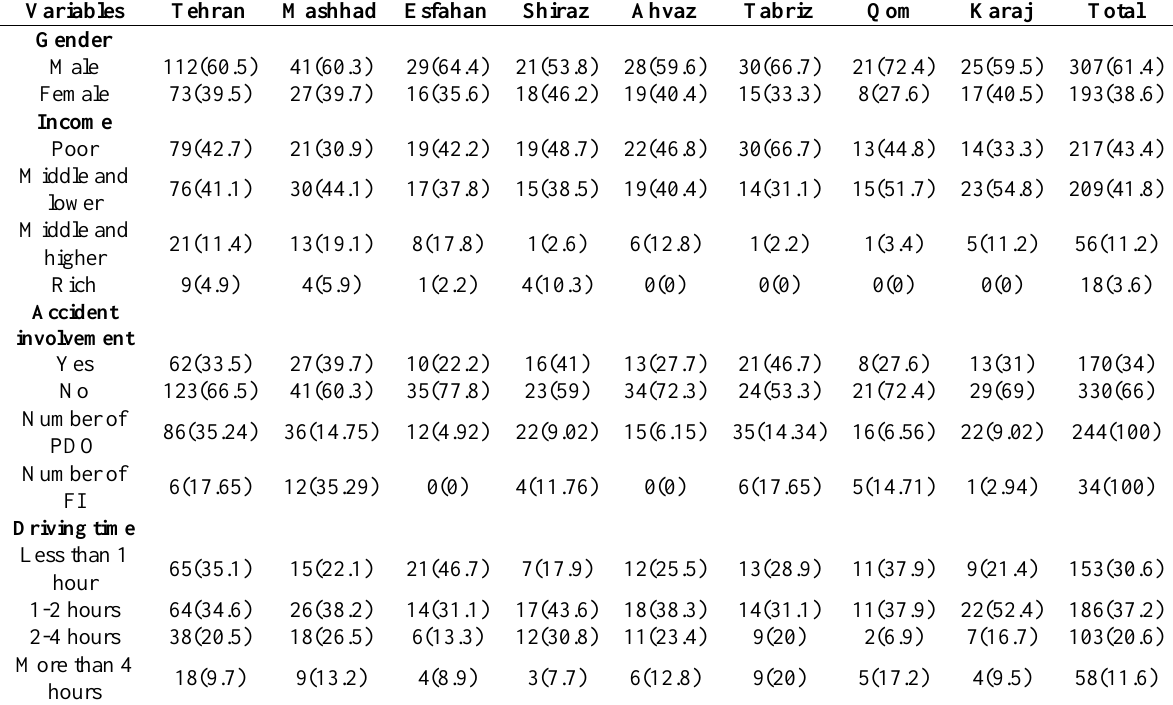
Table 2. Socio-demographic characteristics of drivers surveyed in various metropolises of Iran